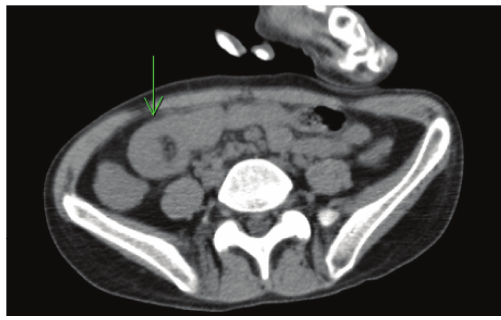
Figure 1: Computed tomography of the abdomen and pelvis reveal- ing concentric, alternating layers of hyperechoic and hypoechoic shadowing within the intestine, suggestive of a duodenojejunal intussusception